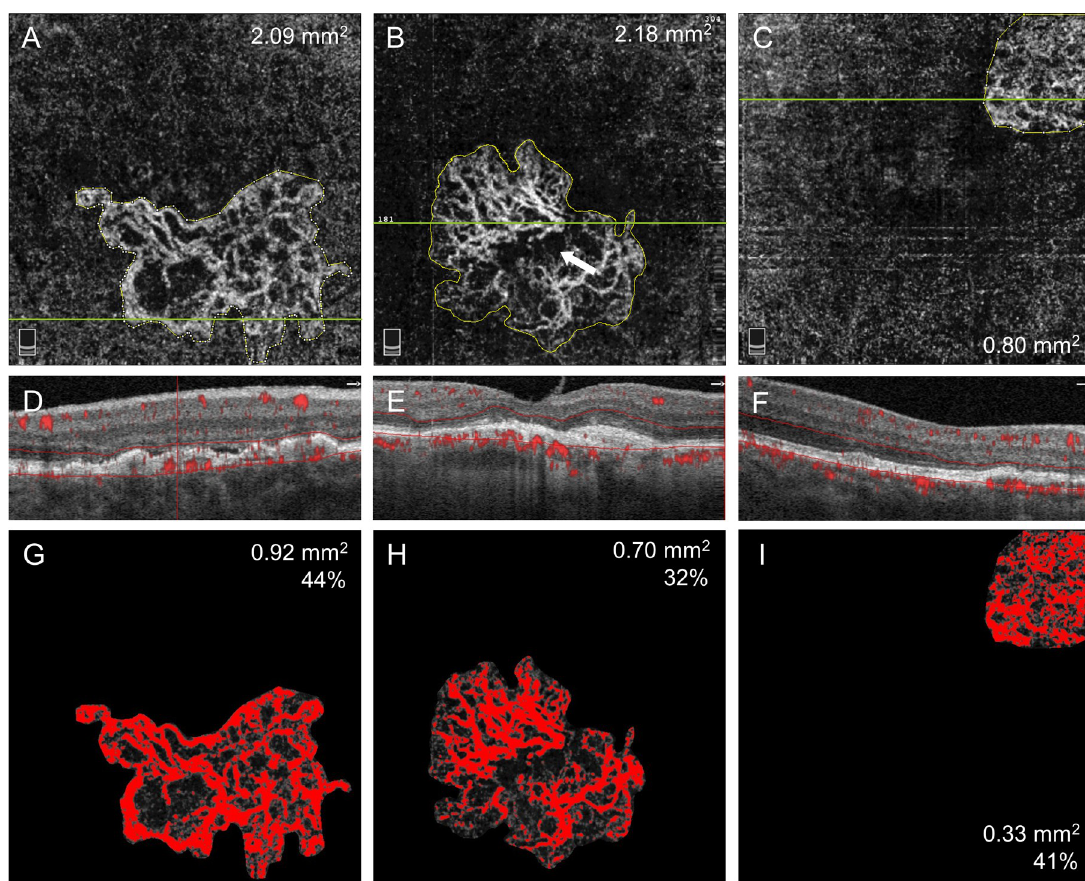
Fig 1. Representative cases in each treatment group demonstrating optical coherence tomography angiography (OCTA) of choroidal neovascularization (CNV) in neovascular age-related macular degeneration. ( Left column ) The right eye of a 73-year-old male in TEq4-6w group receiving anti-vascular endothelial growth factor (VEGF) therapy with 5 weeks interval (post 77 injections) for type 1+2 CNV (type 2 component is not visualized). CNV morphology is classified as irregular in shape, foveal involving, core vessel present, large loops, and mature form. CNV area is 2.09 mm 2 and vessel density is 44%. ( Middle column ) The right eye of an 83-year- old male in TEq7-12w group receiving anti-VEGF therapy with 11 weeks interval (post 21 injections) for type 1+2 CNV. CNV morphology is classified as irregular in shape, foveal involving, core vessel absent, small and large loops, and mature form. CNV area is 2.18 mm 2 and vessel density is 32%. ( Right column ) The right eye of a 75-year-old male in PRN > 12mo group who had not received anti-VEGF therapy for 38 months after 13 injections for type 1 CNV. CNV morphology is classified as circular in shape, foveal sparing, core vessel absent, small loops, and mature form. CNV area is 0.80 mm 2 and vessel density is 41%. A-C, En face OCTA image (3 × 3 mm) of outer retinal slab demonstrate well circumscribed neovascular complex. The manually depicted margin of the neovascular complex is shown in yellow line with CNV area. D-F, OCT B-scans showing fibrovascular retinal pigment epithelium detachment with vascular flow overlay. G-I, Binary processed image of the neovascular complex using Otsu algorism. Vessel flow area and vessel density are shown.